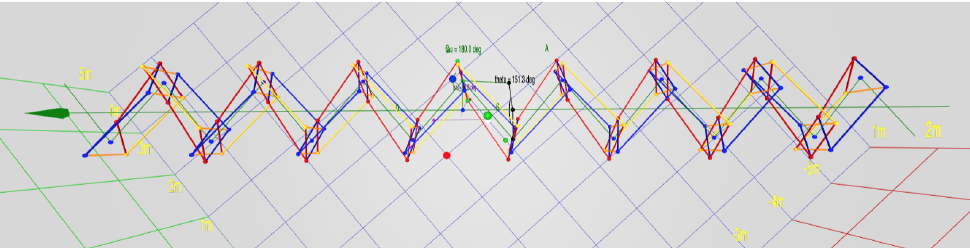
Figure 4. A Planar